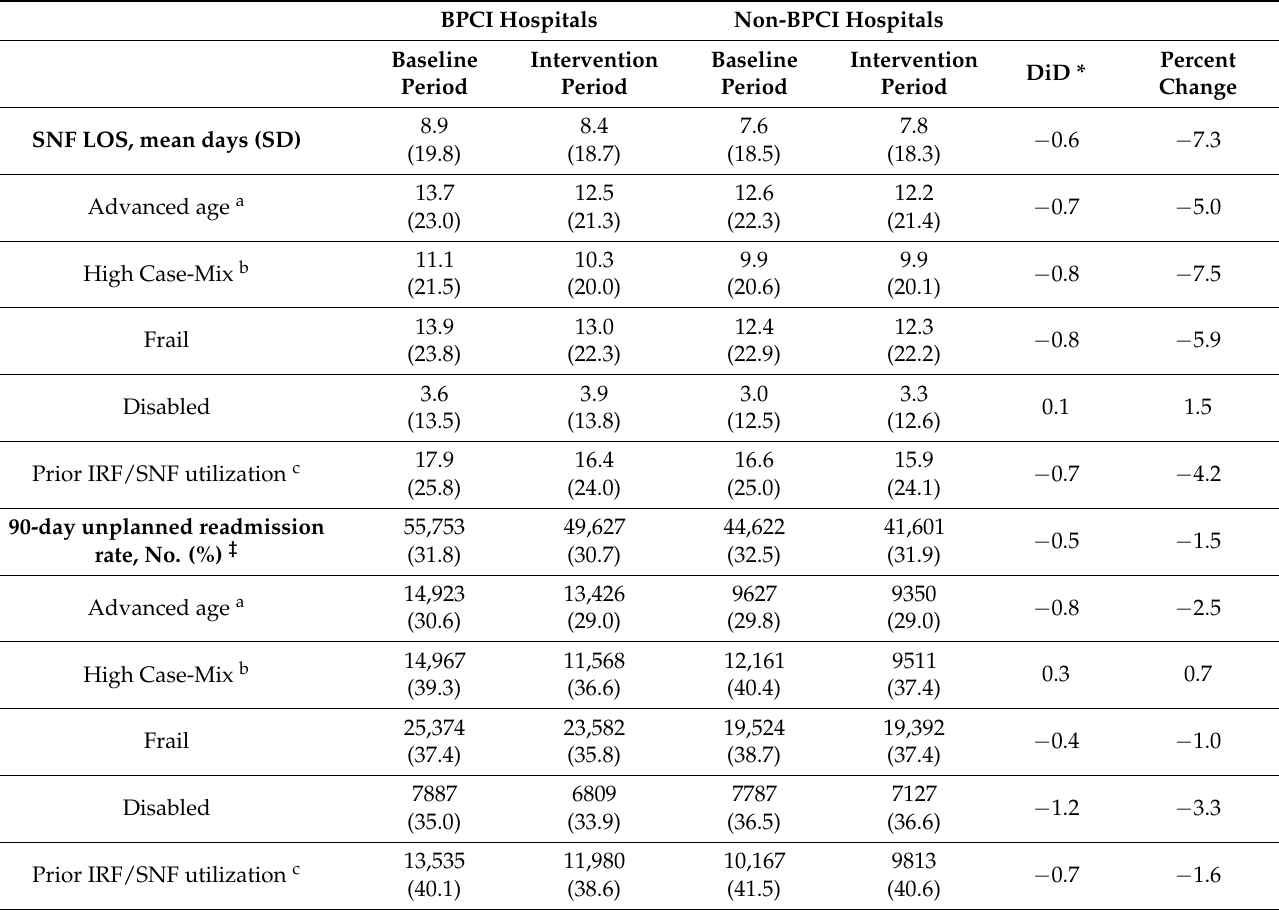
Table 3. Unadjusted Primary Outcomes for Medical Condition Episodes among High-Risk Patients